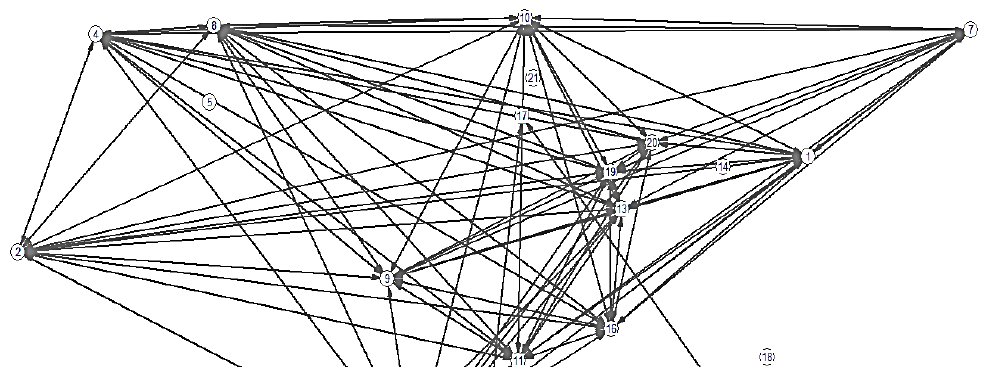
Figure 2. Selecting the trajectory (an example) from top 1 to top 7